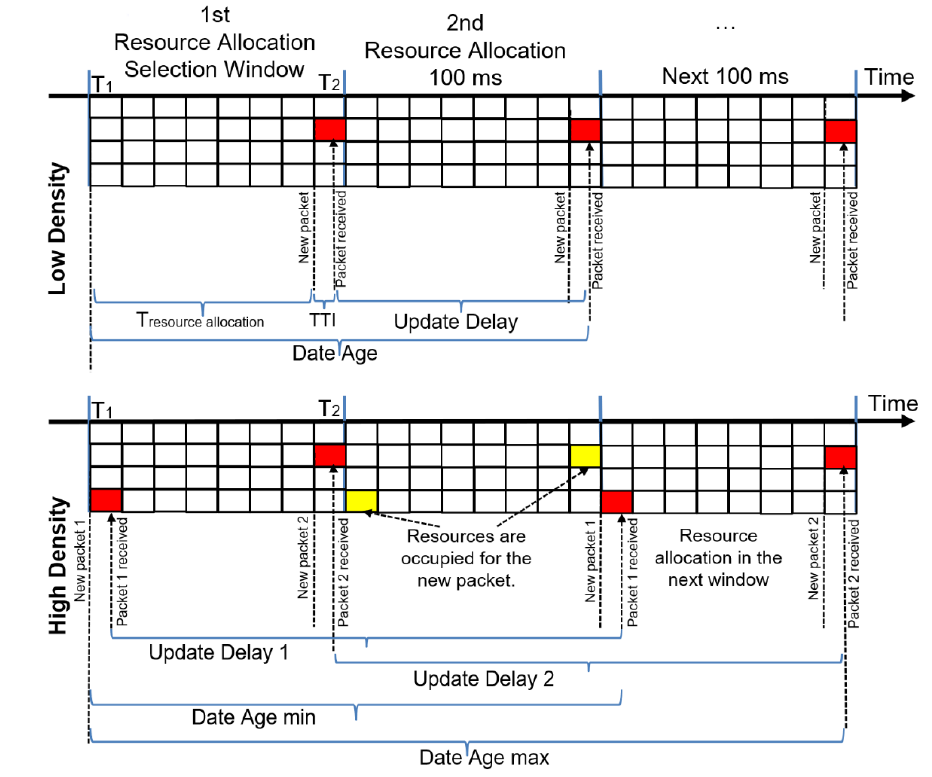
Figure 7. Update delay and date age for